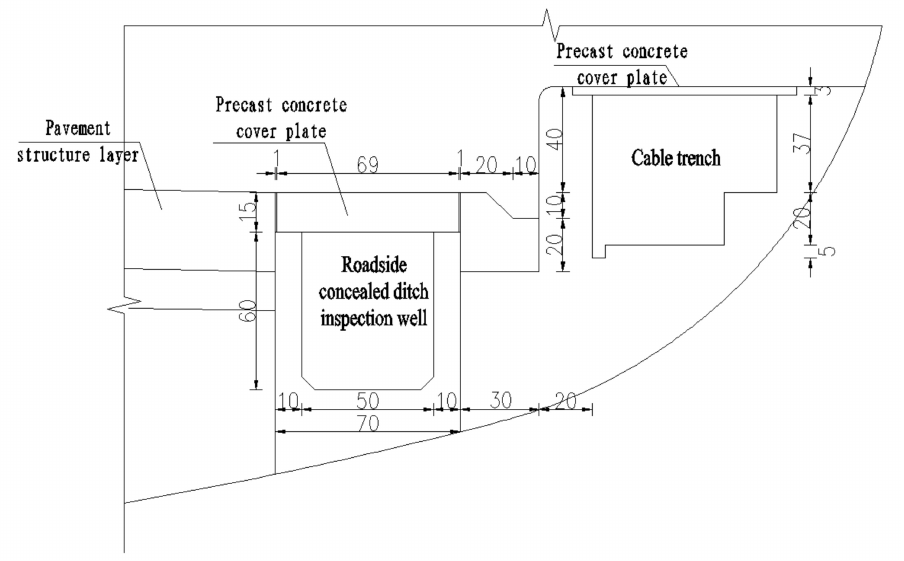
Figure 9. Design drawing of cable trench in China at the present stage (dimensions in the drawing are in cm).